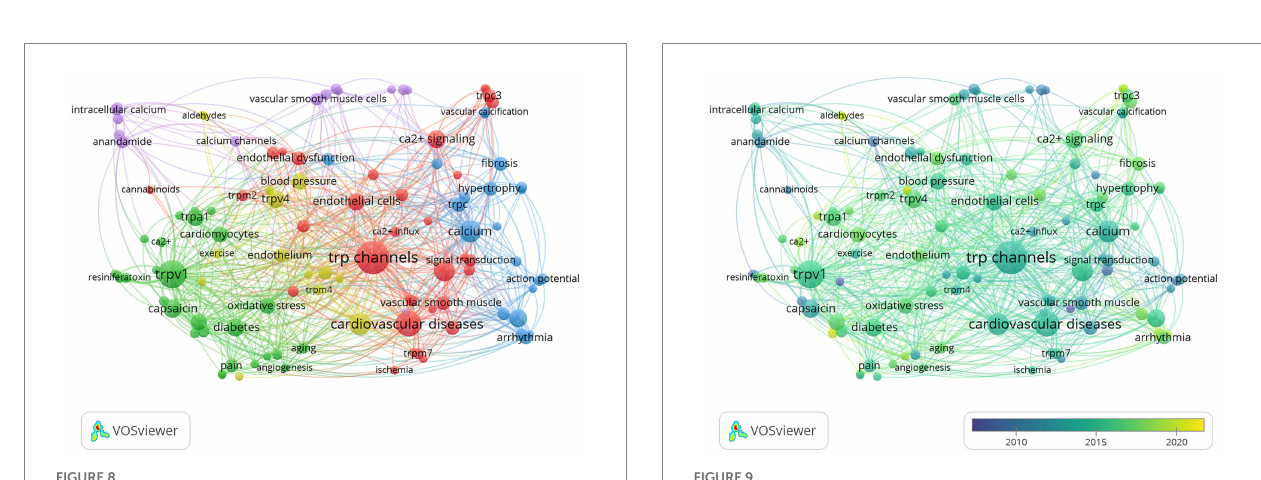
FIGURE 9 These keywords were grouped by year of publication, and the color of the circles represented the average